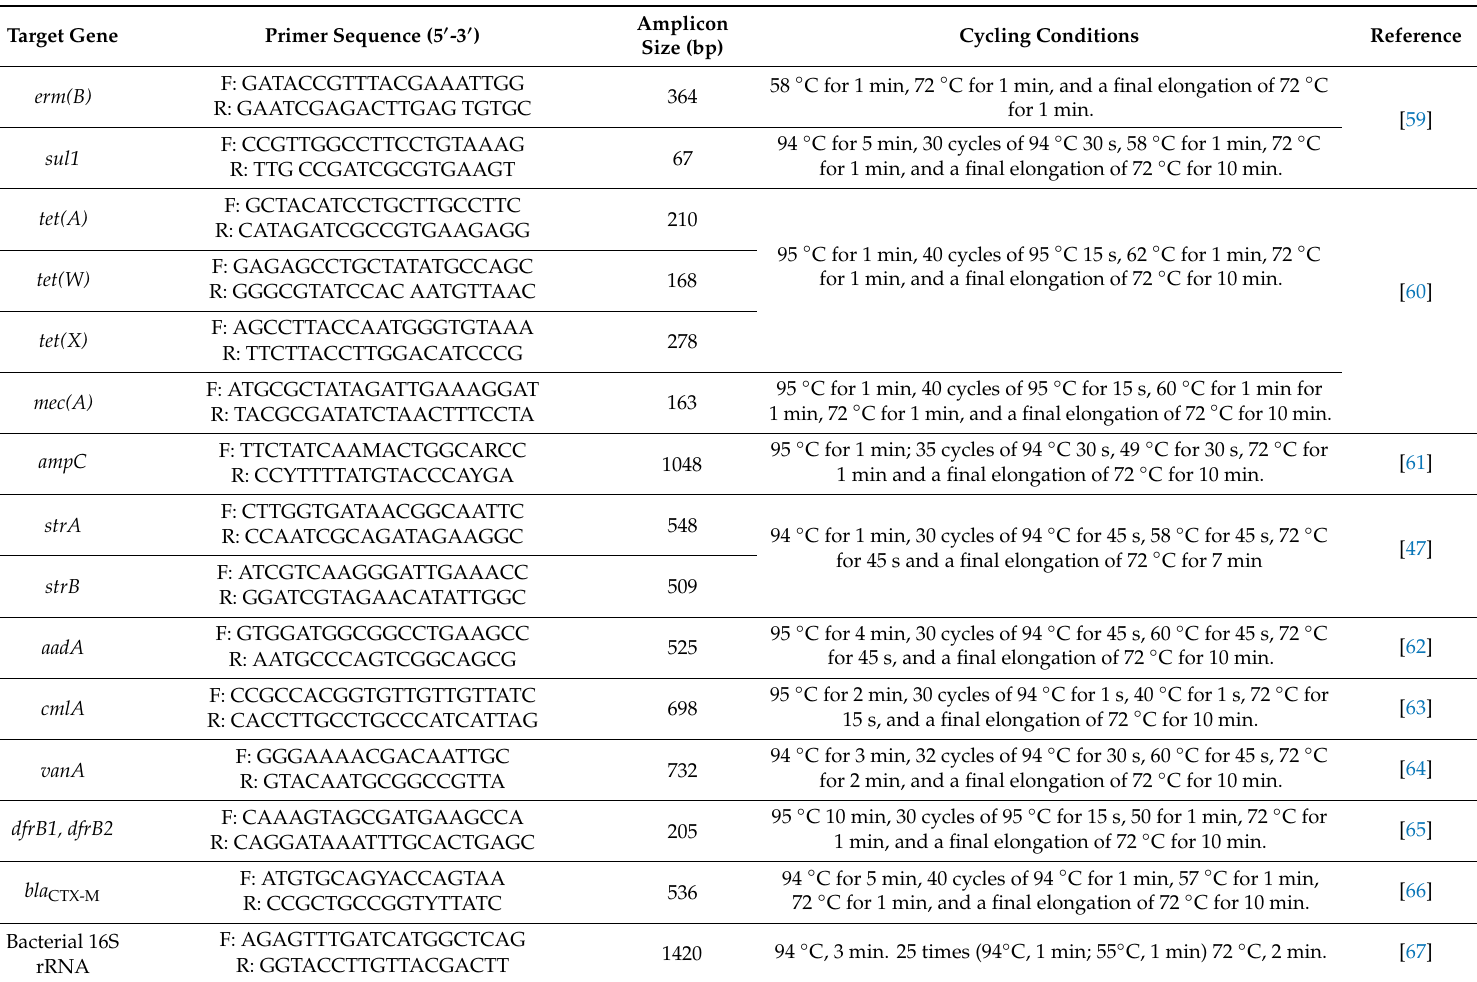
Table 4. Oligonucleotide primers used in the